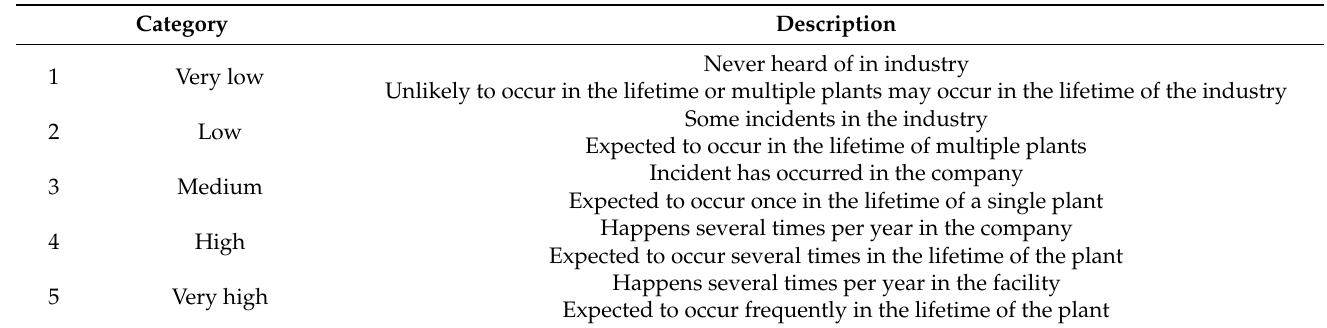
Table 5. Table for exposure category.